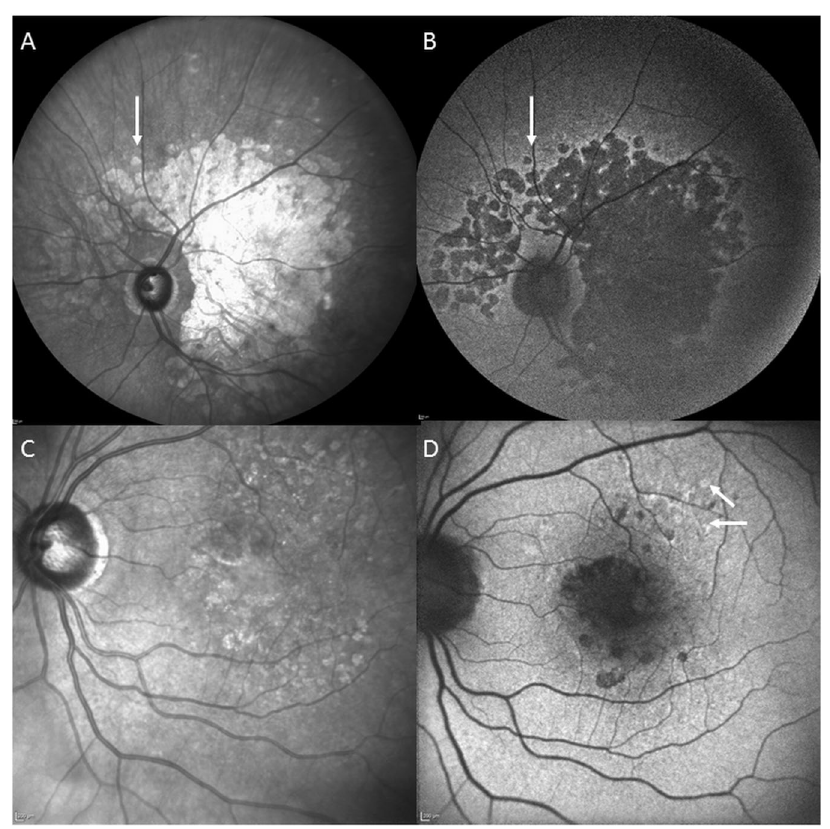
Figure 2. Extensive macular atrophy with pseudodrusen (EMAP) compared to atrophic age-related macular disease (AMD) with pseudodrusen. In EMAP, macular atrophy is extensive with a larger vertical axis passing over the optic nerve head (white arrow) to reach the nasal part of the peripapillary retina ( A ). The atrophy is dark, well-delineated on autofluorescence photograph ( B ). In AMD, there are several patches of macular atrophy restricted to the macular zone ( C ) surrounded by pseudodrusen and classic AMD drusen. On FAF, the atrophic patches are dark and surrounded by mild hyperautofluorescent AMD drusen ( D , white